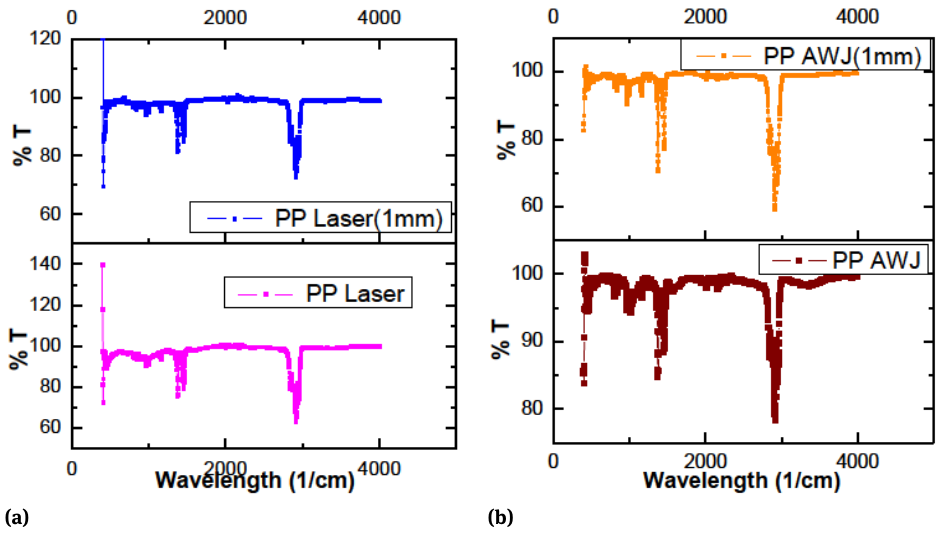
Figure 8: FTIR Images of PP (a) laser sample (b) AWJ cut sample